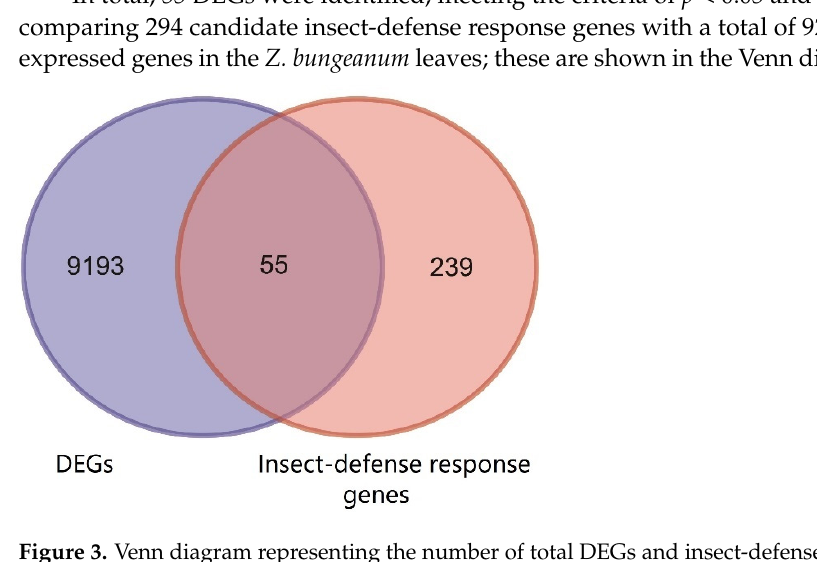
11 of 22 Figure 2. Identification of insect-defense response genes in Z. bungeanum . The boxplots represent the percentage of FPKM value of the “Protease inhibitor,” “Plant lectins,” and “Other defense